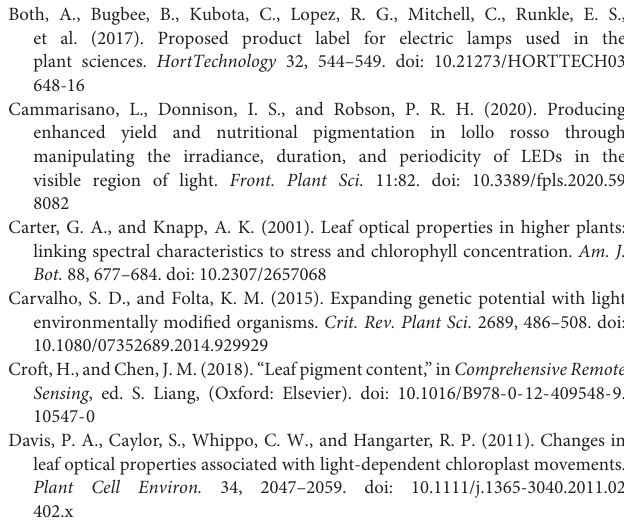
Supplementary Figure 1 | Leaf cross-sections of red lettuce plants grown under two irradiance treatments (270 and 570 µ mol m − 2 s − 1 ) emitted by two different light sources (Fluorescent light and LEDs). Images of leaf cross-sections are at the same magnification. Supplementary Table 1 | Effect of two irradiance treatments (270 and 570 µ mol m − 2 s − 1 ) emitted by fluorescent tubes (FL) and LEDs on leaf disk relative water content (RWC), cell wall thickness, performance index (PI) and non-photochemical quenching (NPQ) of Lollo rosso lettuce at 30